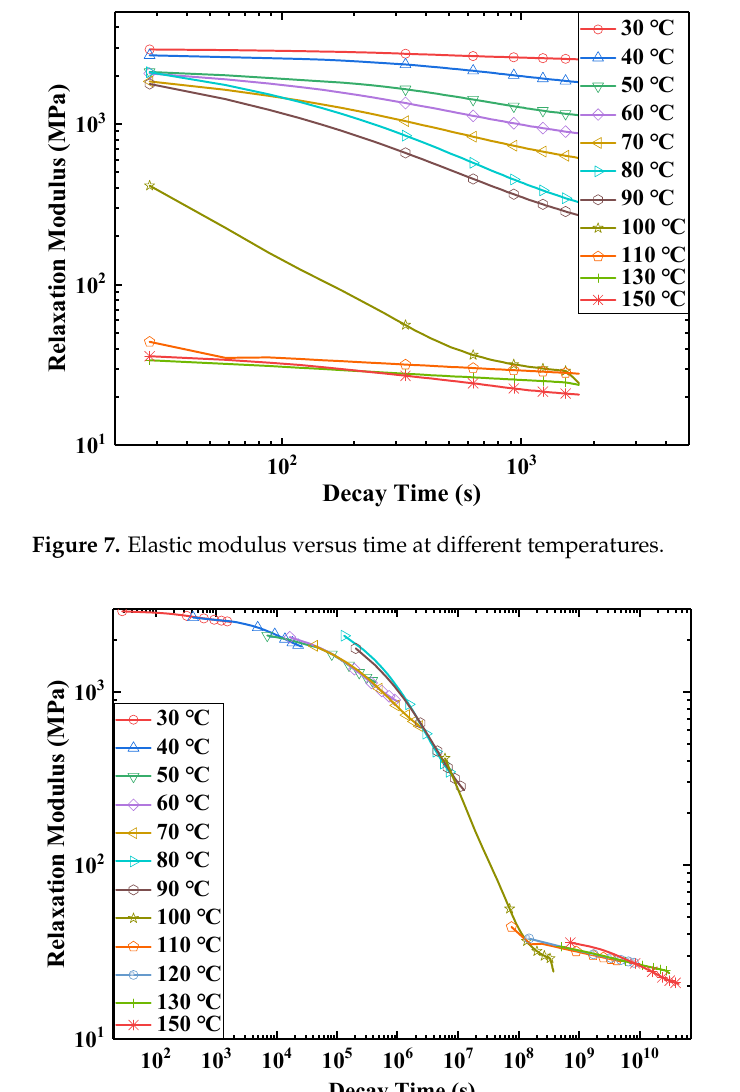
Figure 6. Evaluation curves of hyperelastic parameters at different temperatures.